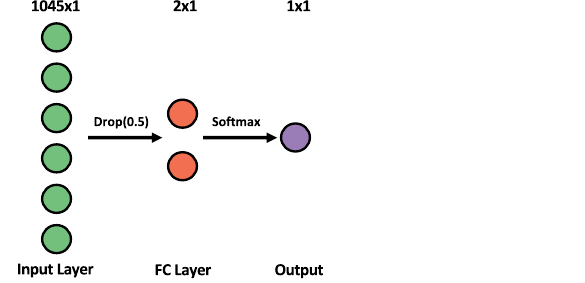
Figure 3. Neuronal network architectures used to develop seizure prediction models. ( a ) Deep neural network, which takes 10-second EEG time series as input. ( b ) Shallow neural network, which is based on EEG